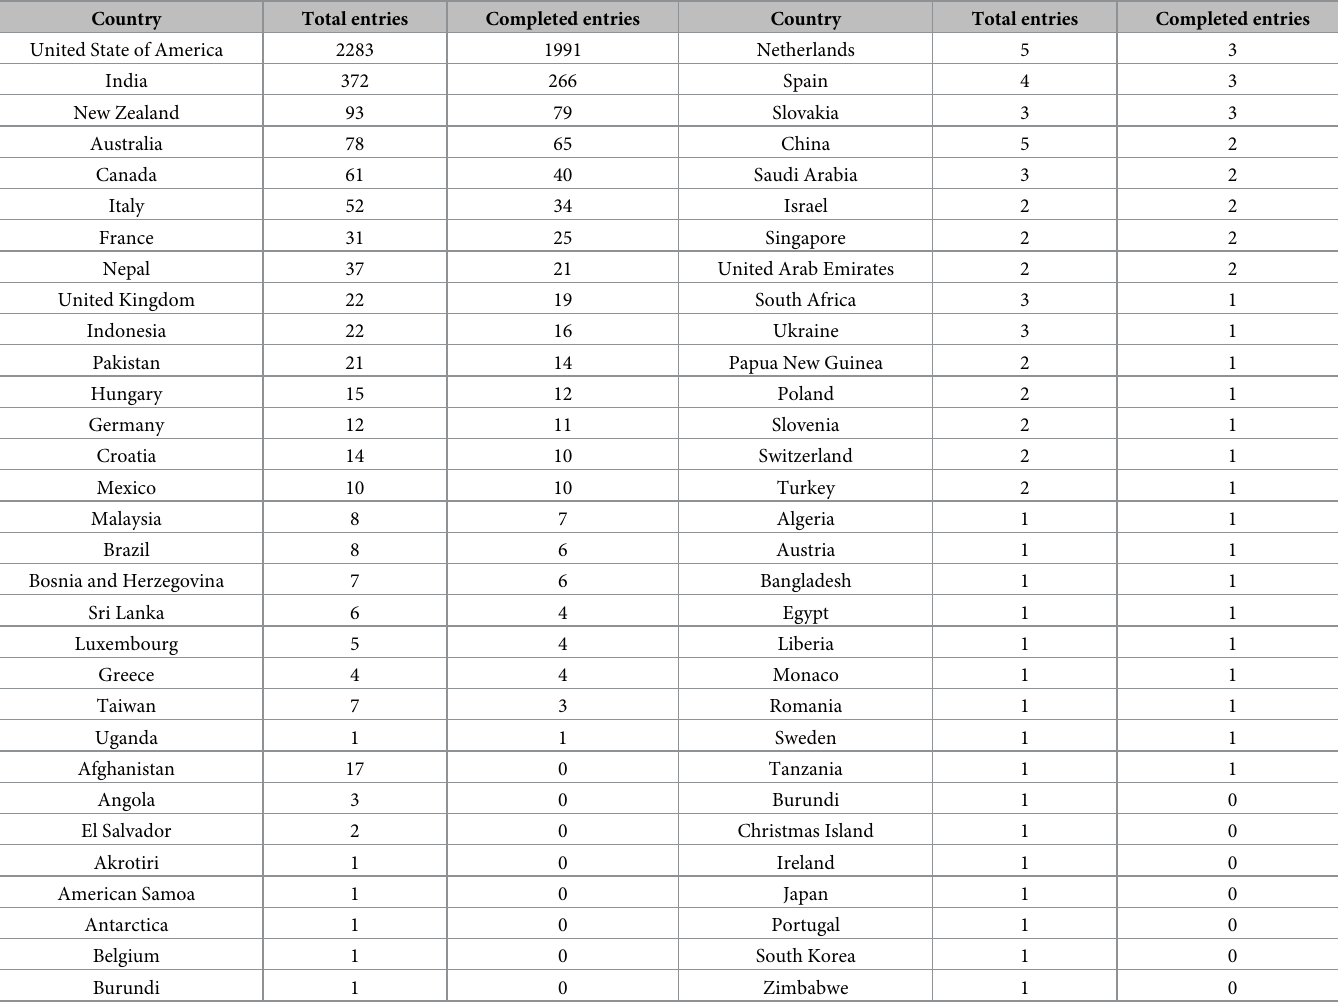
Table 1. List of countries where the survey participants were located, with the corresponding number of participants per